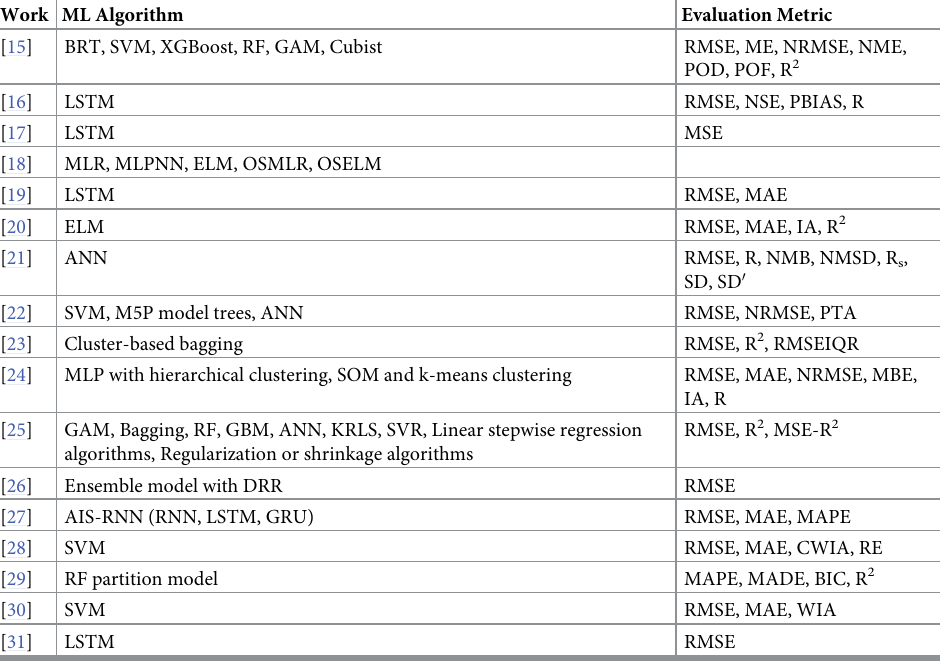
Table 1. Implemented algorithms and evaluation metrics extracted from the publications focused on the predic- tion of NO 2 ( �